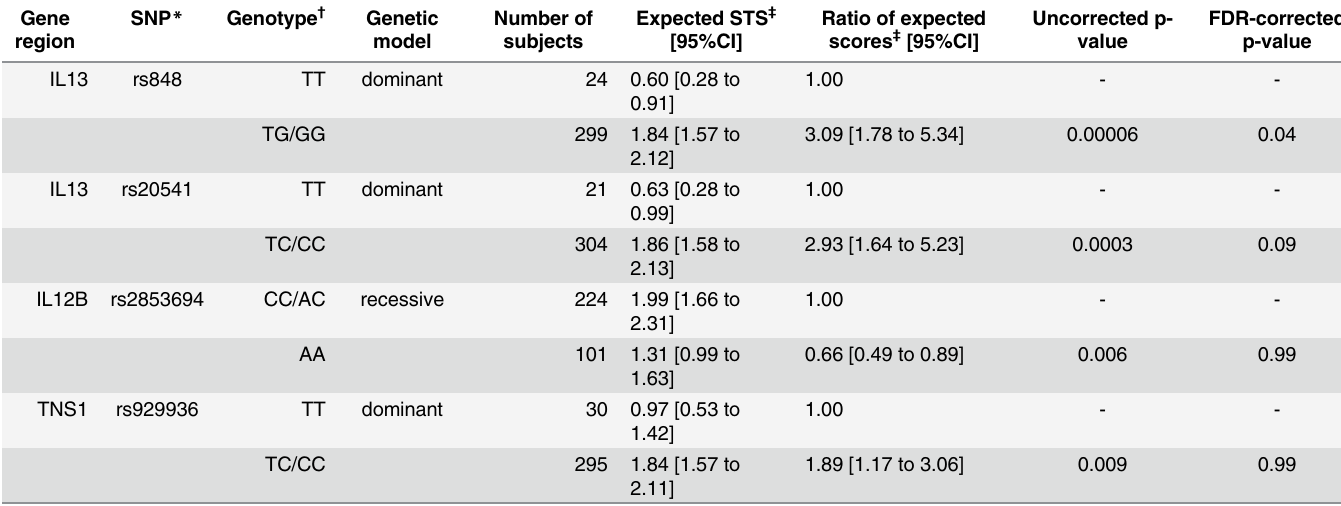
Table 2. Associations with symptom